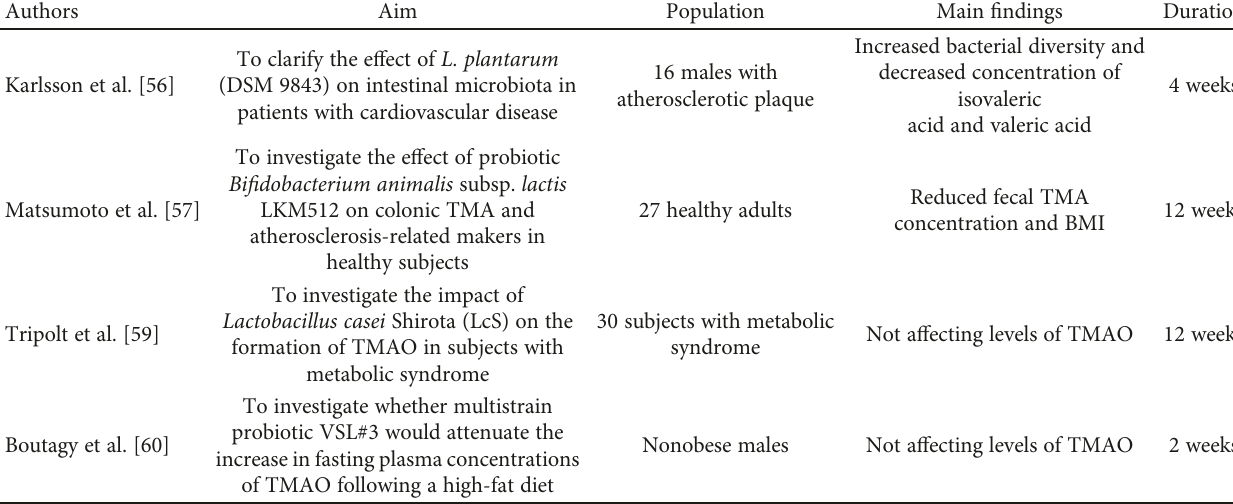
Table 2: Summary of the human randomized controlled trials analyzing the e ff ect of probiotic supplementation on CVD.